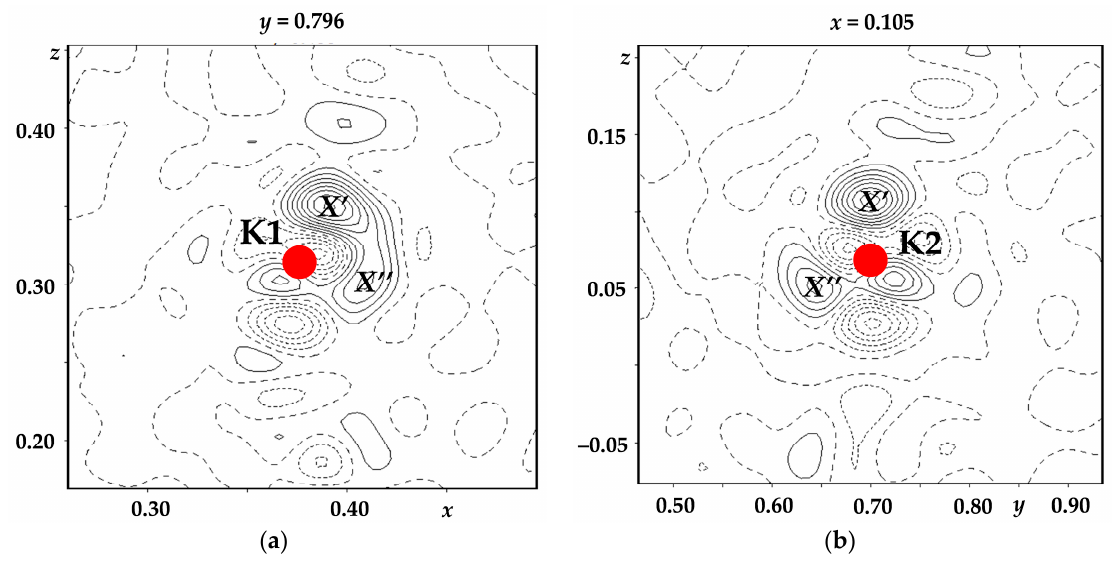
Figure 2. Difference maps of electron density near the positions: ( a ) of the K1 atom; ( b ) of the K2 atom for the crystal grown by the top-seeded solution method. The isolines are drawn in steps of 0.1 e Å − 3 . In accordance with these peaks, the atoms K1 (cid:48) , K1”, K2 (cid:48) , and K2” were localized. The occupancies of the main and additional potassium positions were refined by the step-scan technique [47], which makes it possible to avoid a strong correlation between the atomic displacement parameters and the position occupancies. The final occupancies were assumed to be equal to the values corresponding to the midpoint of the confidence interval within which the discrepancy factor retained its minimum value. The error in the refinement was registered as equal to half the confidence interval. The occupancies of the main and additional positions of potassium atoms, as well as the distances between them, are listed in Table